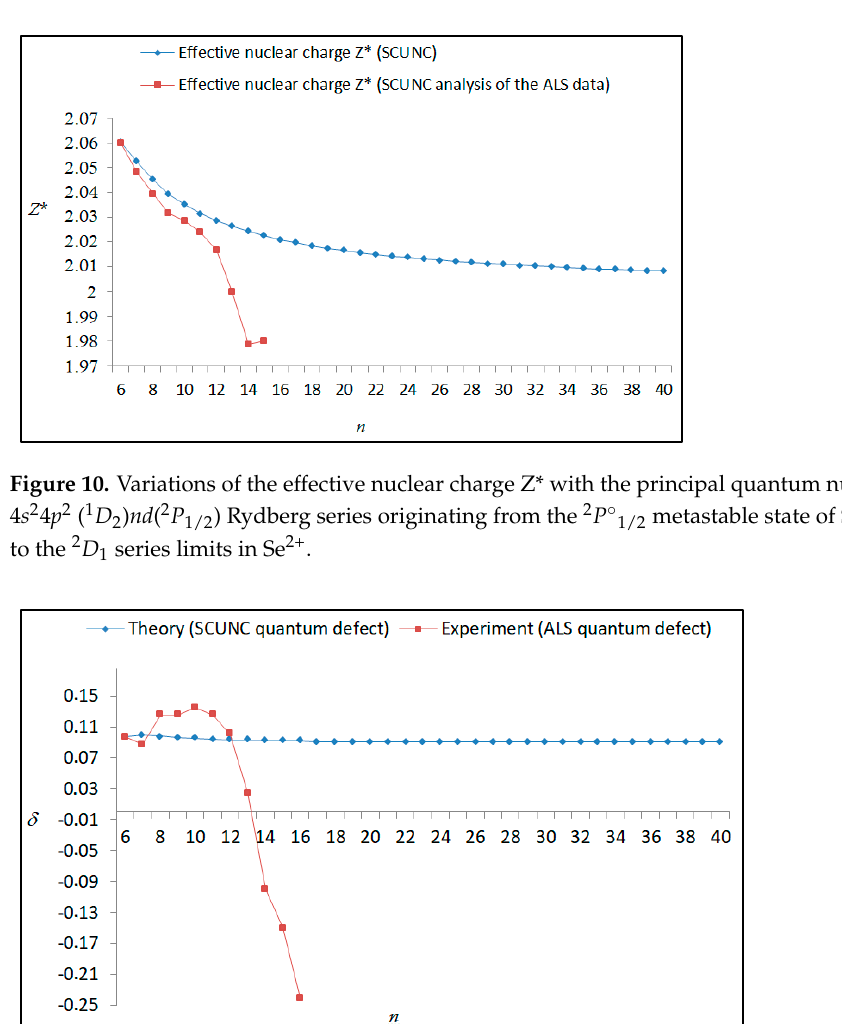
Figure 9. Variations of the quantum defect ( δ ) with the principal quantum number n for the 4 s 2 4 p 2 ( 1 D 2 ) nd ( 2 P 1/2 ) Rydberg series originating from the 2 P ° 1/2 metastable state of Se + converging to the 2 D 1 series limits in Se 2+ .